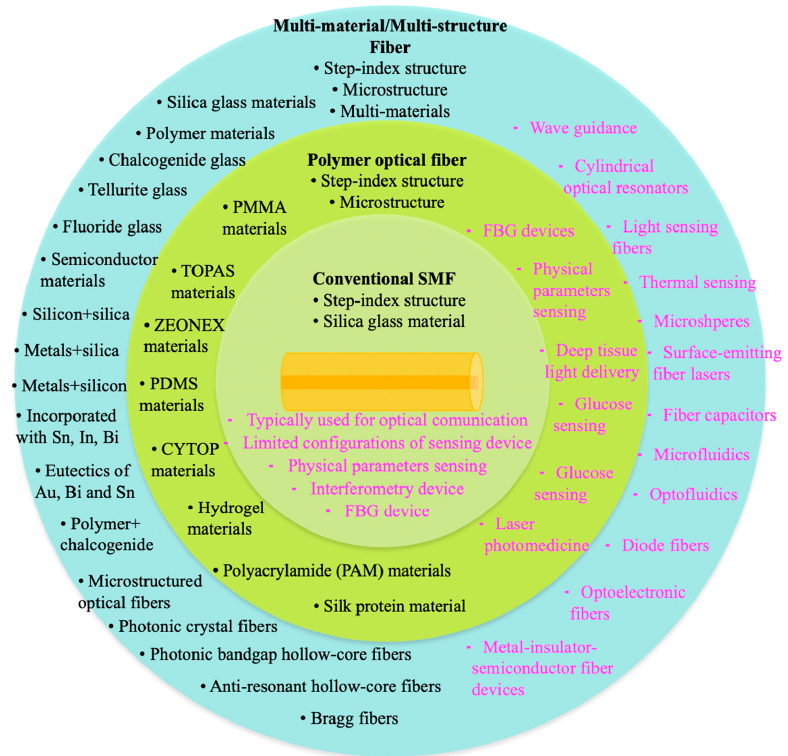
Figure 1. Summary of typical materials and functions for conventional SMF, polymer optical fibers, and multi-material